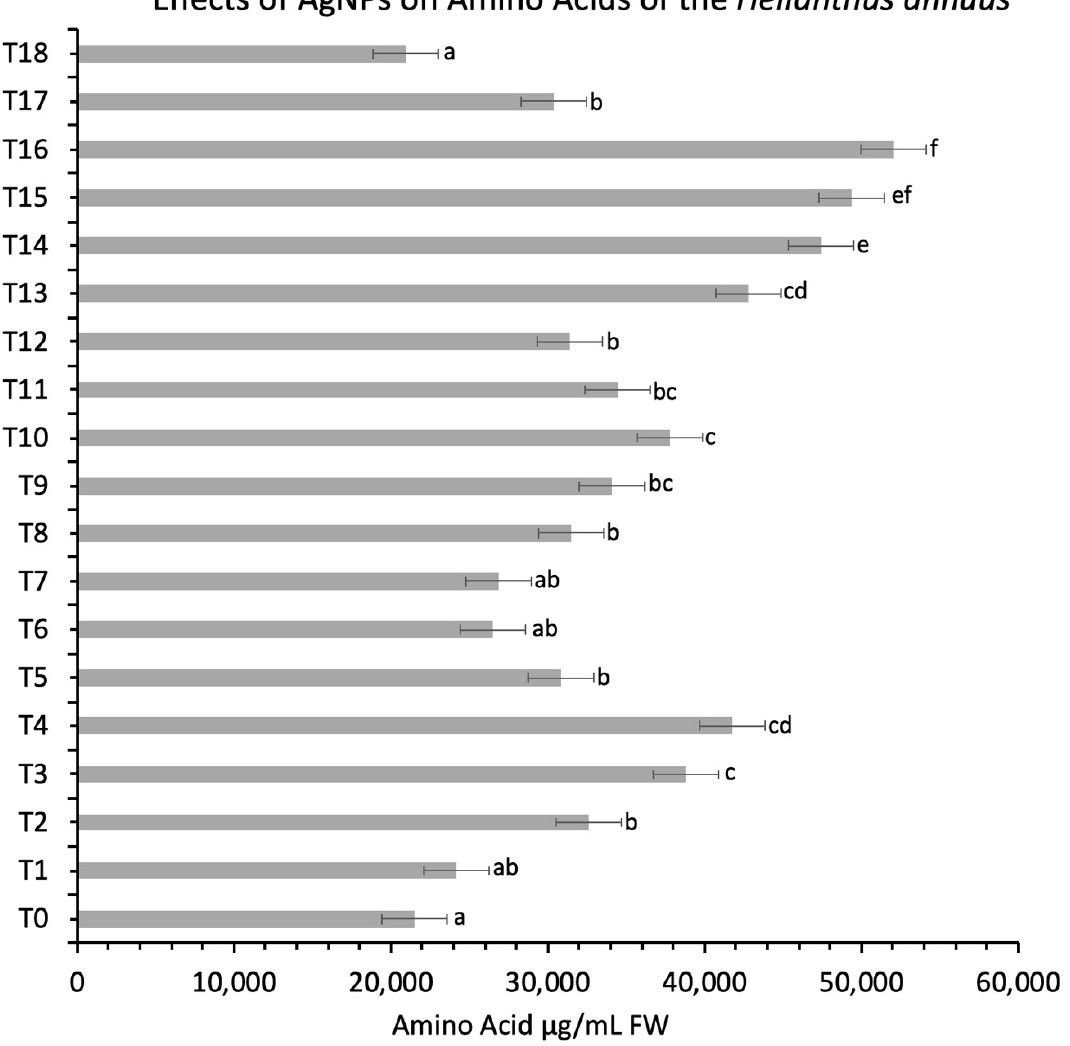
Figure 7. Effects of different treatments of AgNPs on amino acid contents of sunflower. Lowercase letters differed significantly at 5% probability levels, using Duncan’s Multiple Range Test ( p < 0.05).